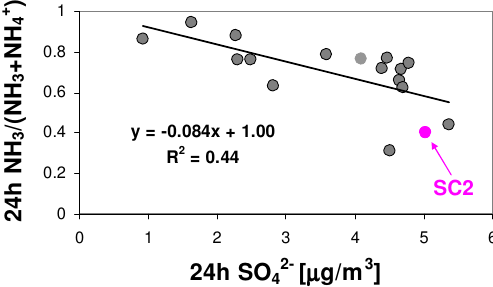
Fig. 12. Relationship between the gas fraction of ammonia ) concentrations from 24h (NH 3 /(NH 3 +NH 4 + )) and sulfate (SO 2 − 4 filters collected over the period 10 May–5 August at